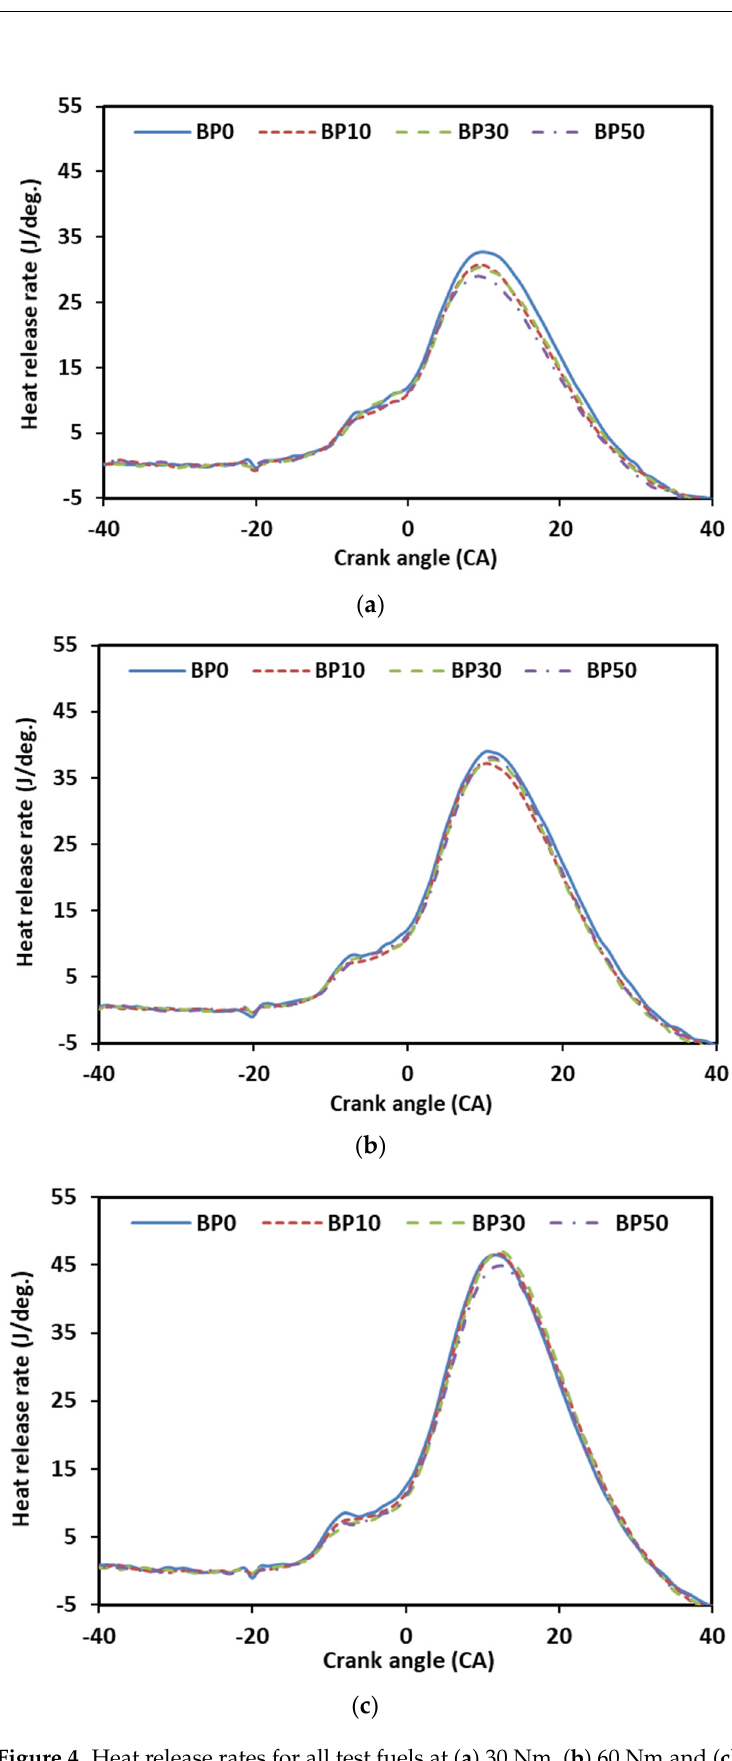
Figure 4. Heat release rates for all test fuels at ( a ) 30 Nm, ( b ) 60 Nm and ( c ) 90 Nm.